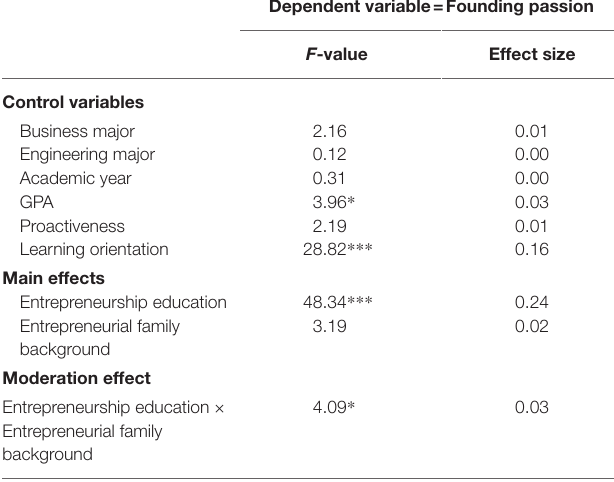
TABLE 5 | Two-way ANOVA results.